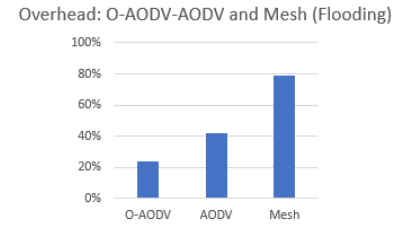
Figure 25. Overhead: O-AODV, AODV, and mesh (flooding).